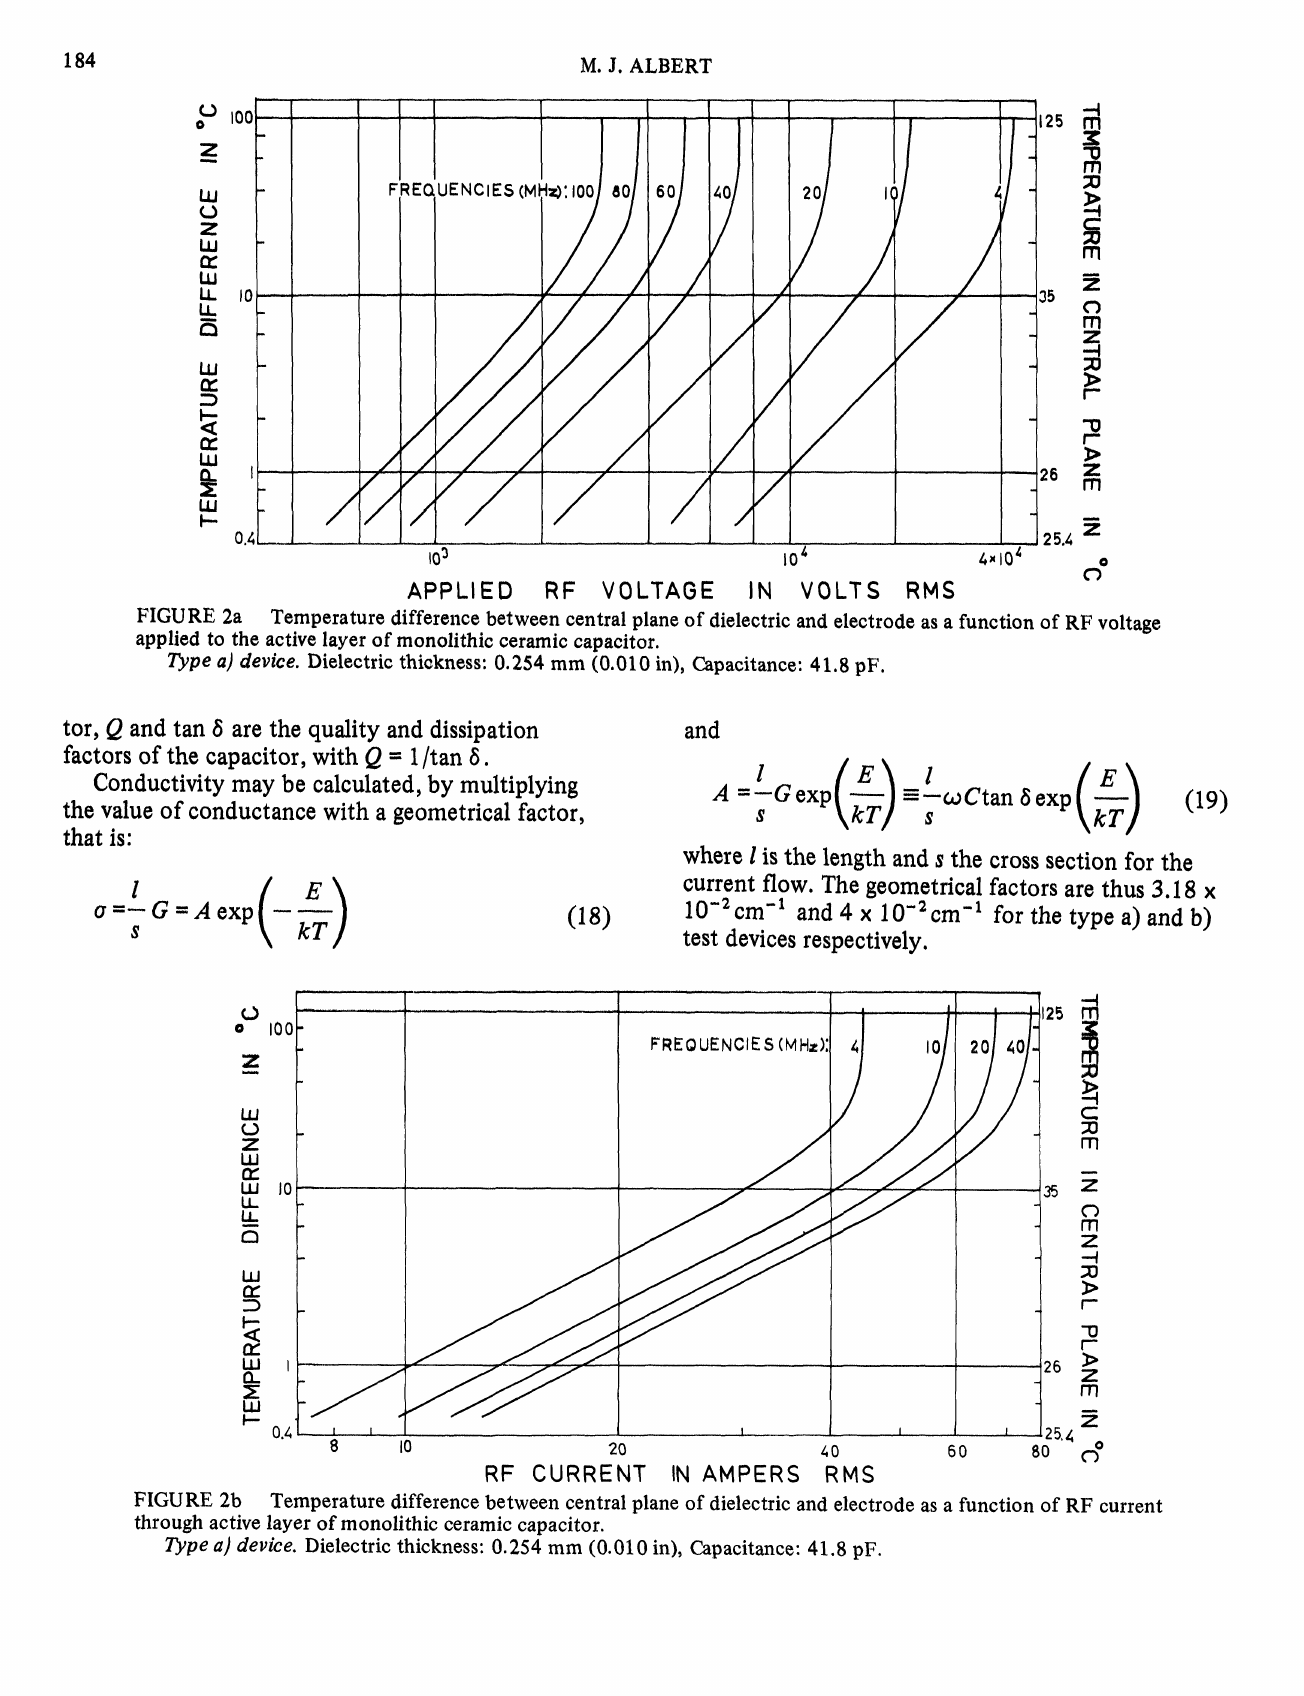
Tempeatze iffeece beteea central plae of ielectdc a elect[oe active laye[ o monolithic ce[amic capacito[. a) depiee. Dielect[ic thickness: 0.254 m (0.010 i), acitace: